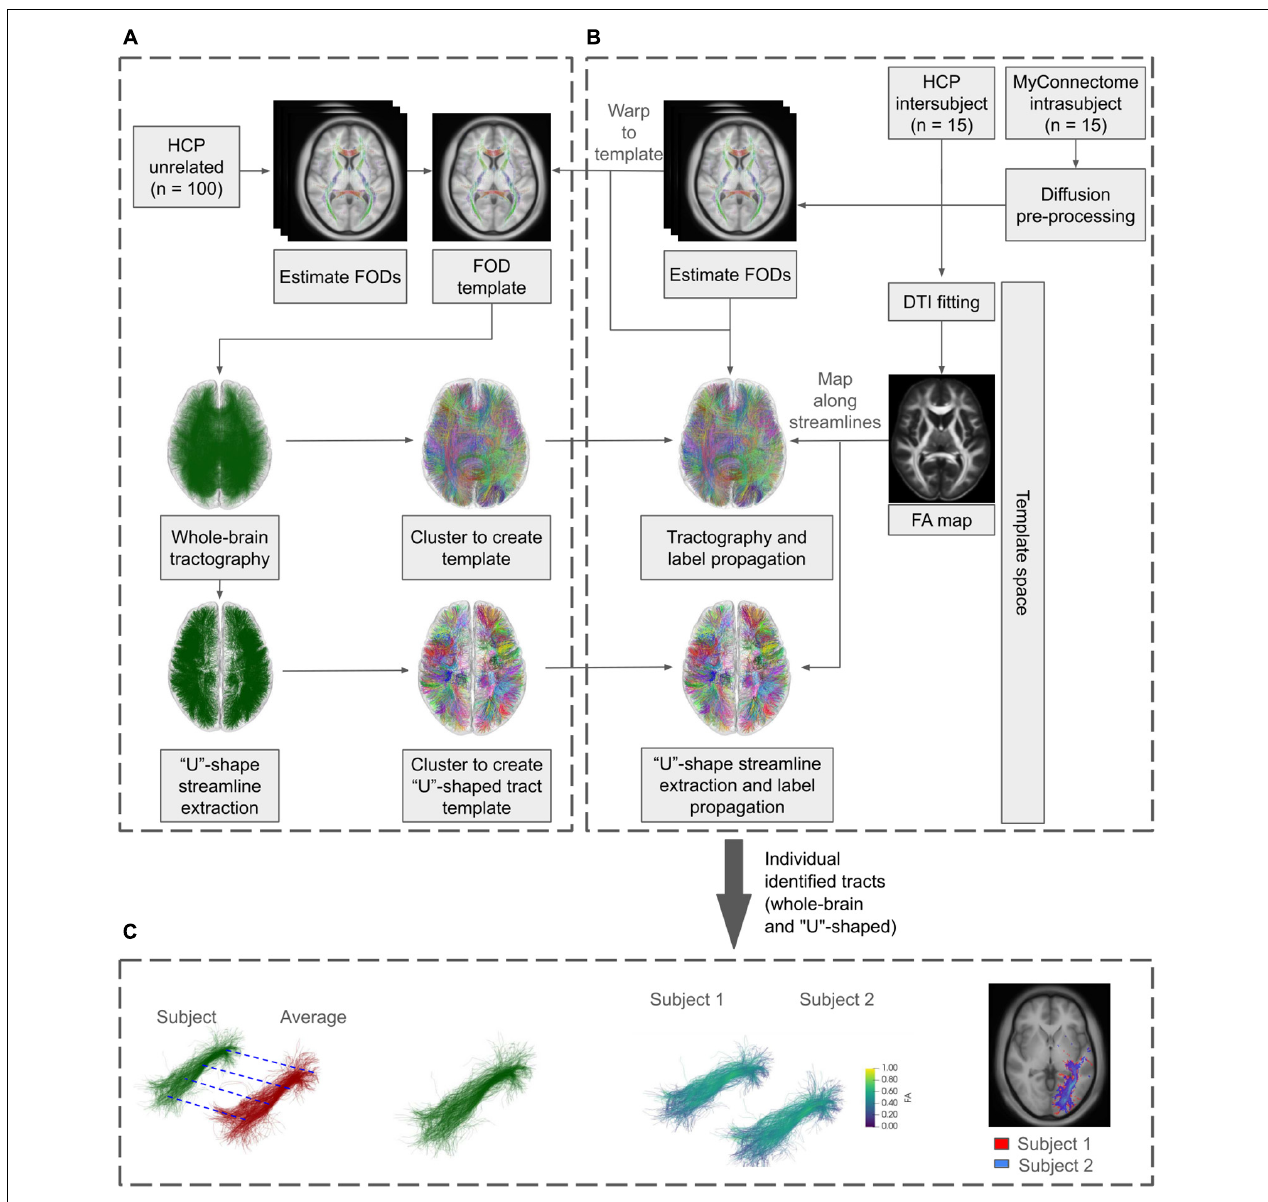
FIGURE 1 | General diffusion processing workflow using minimally preprocessed HCP and unprocessed MyConnectome data. (A) HCP unrelated subjects were used to create the population-based FOD template. Whole-brain and “U”-shaped tractography was created from the FOD template and streamlines were assigned labels via clustering, creating labeled tractography templates. A subset of each identified tract is extracted and used to propagate labels to the analysis datasets. (B) MyConnectome data was first preprocessed using in-house pipelines. Together with minimally preprocessed the HCP dataset, individual FODs were computed and warped to the previously created template. Tractography was performed for each subject/session in the template space. Additionally, DTI fitting was performed and mapped along the generated streamlines. Labels from the tractography template were propagated to subject/session’s tractography. (C) Analysis was performed on the identified tracts, evaluating Euclidean distances and tract overlaps both within each dataset and against the labeled template. In addition, streamline counts and along-tract agreement of FA were assessed within each